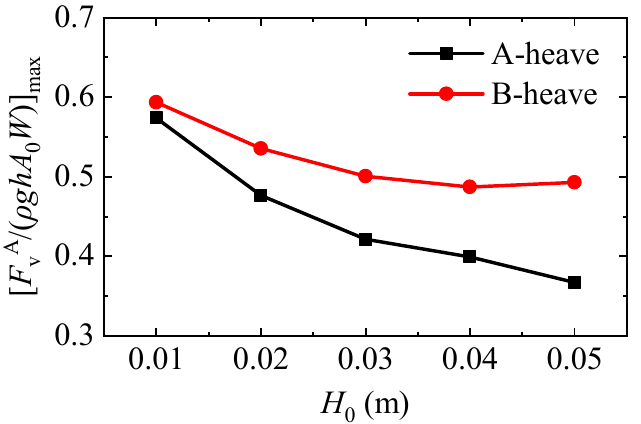
Figure 11. Variations of the normalized largest vertical wave force on Box A, [ F vA /( ρ ghA 0 W )] max , against the incident wave height.